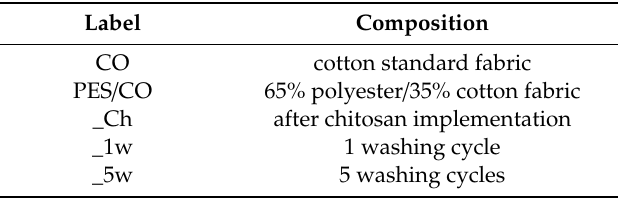
Table 1. Labels and treatment of CO and PES / CO fabrics. Label